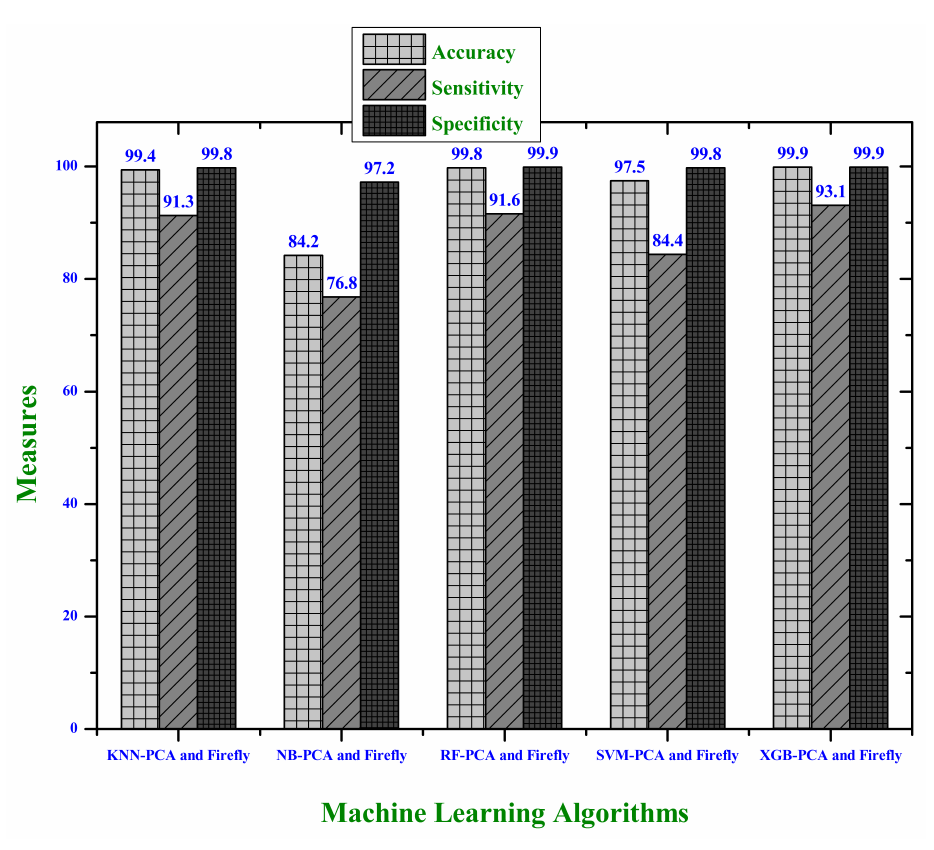
Figure 9. Comparative analysis of machine learning algorithms with proposed approach.